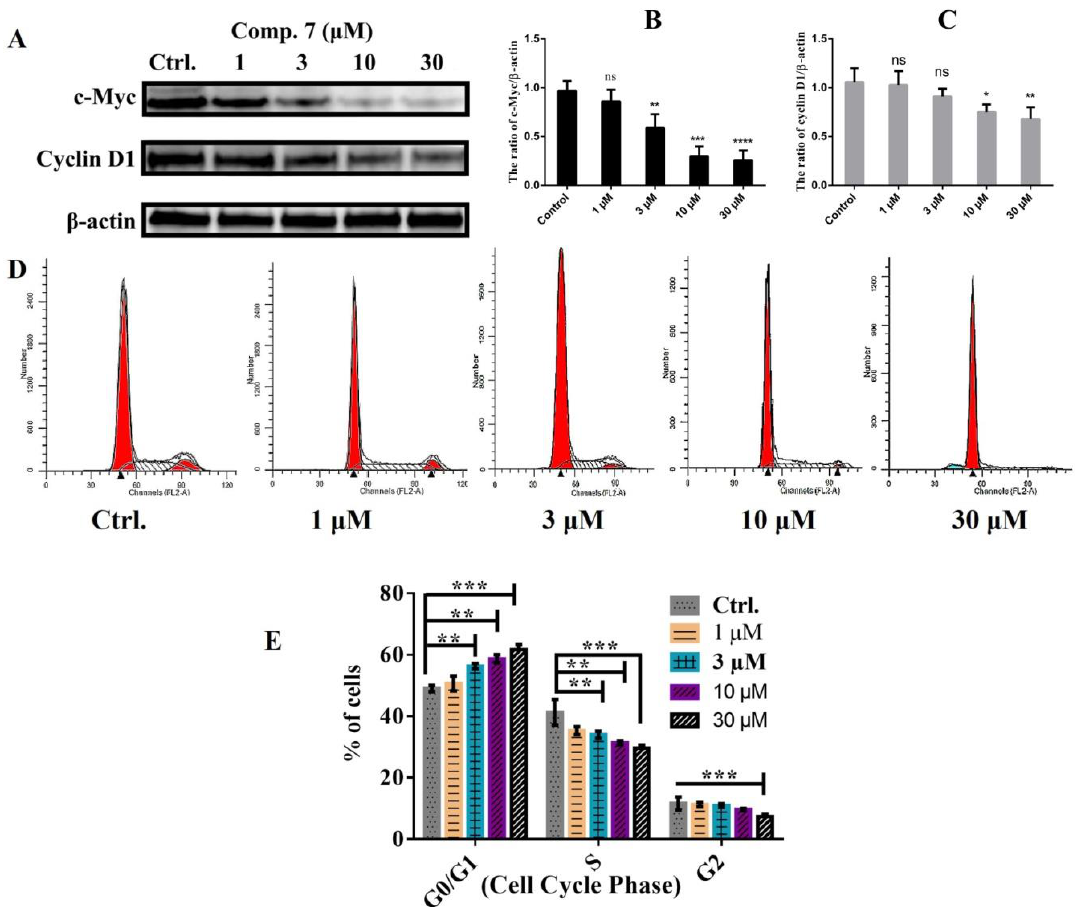
Figure 3. The effect of compound 7 on breast cancer MCF-7 cell cycle. The cells were plated overnight and then treated with compound 7 at the indicated concentrations for 48 h. ( A ) The western blot was performed using antibody against cyclin D1 and c-Myc. β -actin was used as internal control for western blot analysis. ( B , C ) The results of the Western blotting in cyclin D1 and c-Myc were evaluated in three independent experiments and normalized with β -actin. ( D , E ) After treating the cells with varying concentrations of compound 7 , the cells were collected and fixed with 75% ethanol and then re-incubated in PBS with RNase and then stained with propidium iodide and then subjected to flow cytometry for DNA content was determination percentage at various cell cycle phases. * p < 0.1, ** p < 0.01, *** p < 0.001, **** p < 0.0001 versus the control group, ns : no significant